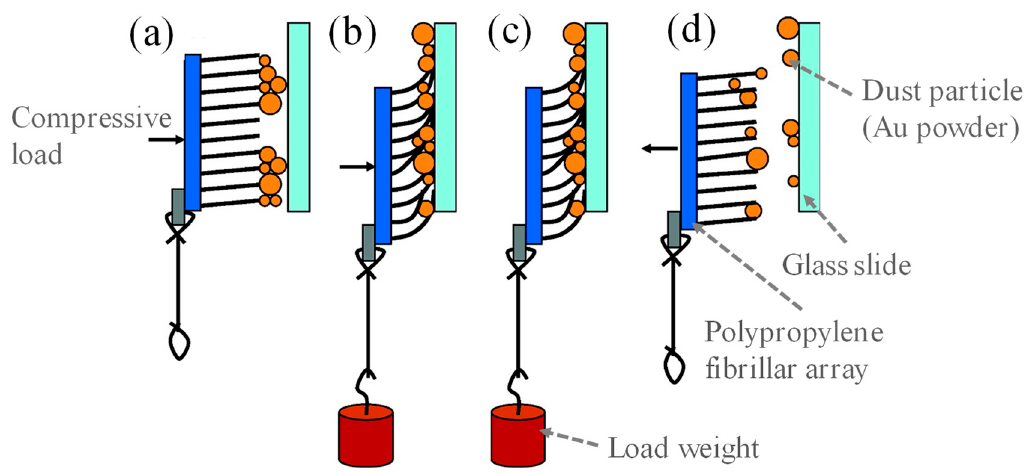
Figure 17. Standard protocol of mimicked gecko step cycle: ( a ) Normal compressive force was applied on the back side of the fiber substrate. ( b ) Applying shear load added to the compressive force. ( c ) Removing the compressive force to make the load a pure shear force. ( d ) Detaching the sample from the clean surface. Reproduced with permission from [153], published by ACS Publications, 2008.